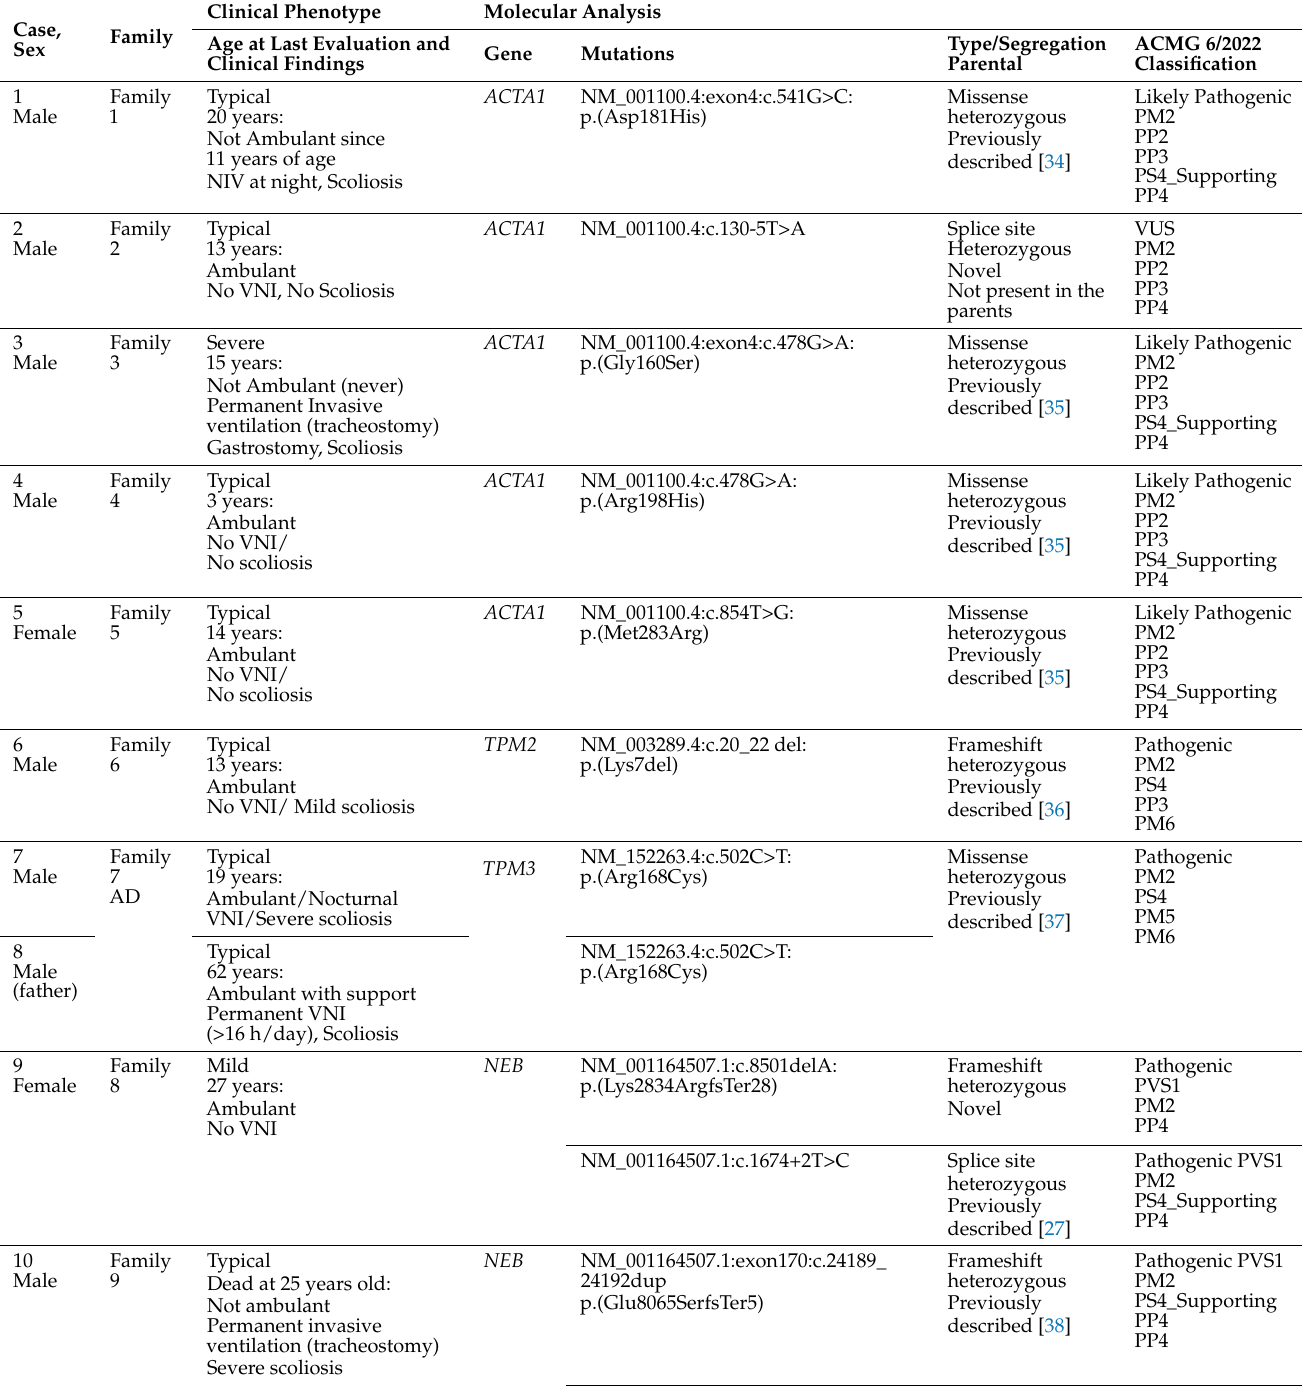
Table 1. Clinical and molecular data of the patients. Abbreviations: ACMG: American College of Medical Genetics and Genomics; NIV: Non-invasive ventilation; VUS: Variant of uncertain